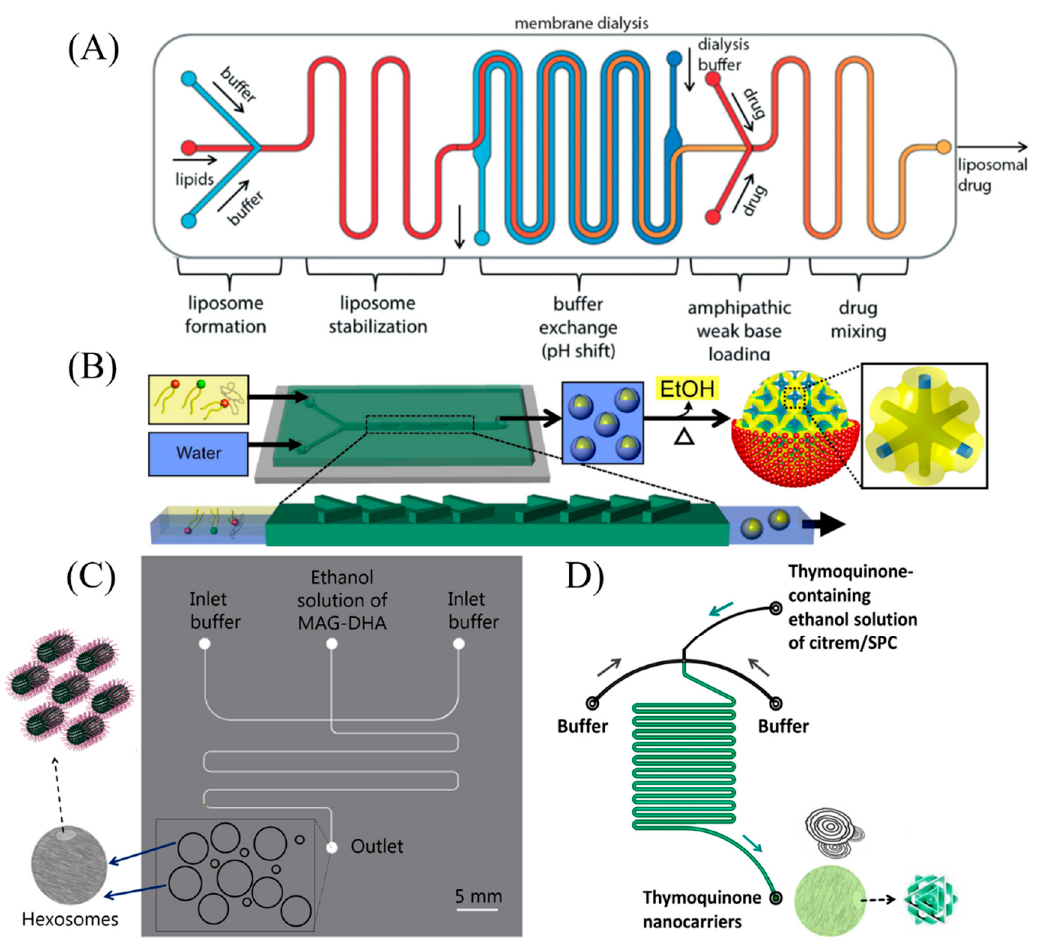
Figure 1. Schematic illustrations of continuous production of drug-free and drug-loaded lipid nanoparticles including liposomes, cubosomes, and hexosomes. ( A ) Multifunctional microfluidic device for rapid single-step microfluidic synthesis of monodispersed liposomes and their remote loading with therapeutics. Reprinted with permission from [27]. 2014, the Royal Society of Chemistry. ( B ) Staggered herringbone mixer for microfluidic synthesis of siRNA-loaded cubosomes. The continuous production includes additional chip-off step for evaporation of ethanol. Adapted with permission from [18]. 2018, the American Chemical Society. ( C ) Hydrodynamic flow-focusing (HFF) polyimide microfluidic device for microfluidic synthesis of Pluronic F127-stabilized hexosomes based on docosahexaenoic acid monoglyceride (MAG-DHA). Reprinted with permission from [19]. 2019, the Royal Society of Chemistry. ( D ) Continuous production of lamellar and non-lamellar liquid crystalline nano-self-assemblies (liposomes and cubosomes) for delivering the therapeutic agent thymoquinone by using a simple commercial microfluidic. Reprinted from [17]. 2021, MDPI.